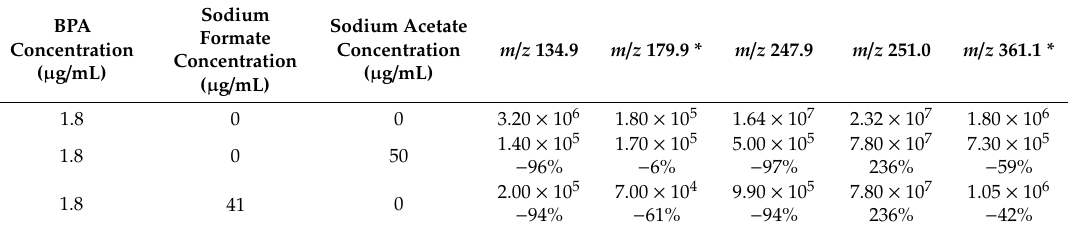
Table 1. E ff ects of sodium formate and acetate on electrospray ionization-ion trap mass spectronomy (ESI-ITMS) peak intensities (and their percentage changes) for bisphenol A (BPA) at m / z 134.9, m / z 247.9, and m / z